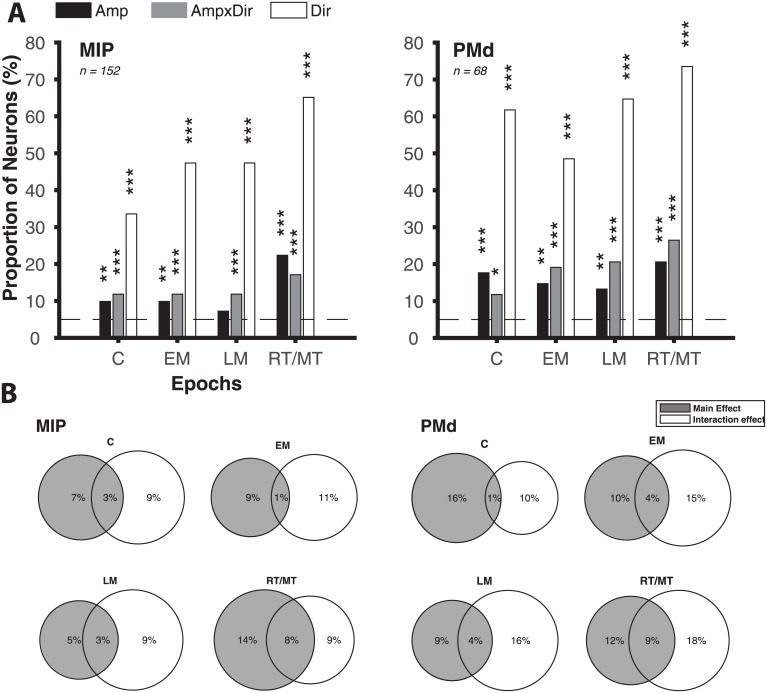
(A) Population analysis of modulation by reach direction and amplitude for both tasks. The proportions of neurons that varied their activity significantly due to the instructed reach direction (black bars), instructed reach amplitude (gray bars), and an interaction of direction and amplitude (white bars) are shown for each of four trial epochs. The two panels correspond to task-related neurons recorded from MIP and PMd respectively, pooling across both target configurations. The proportion expected by chance (“null”, obtained by randomly shuffling the data) is shown with the black horizontal line. Asterisks indicate significance of proportions relative to chance (*: p < 0.05, **: p < 0.01, ***: p < 0.001). (B) Main and interaction effects of reach amplitude. For each cortical area and trial epoch, a Venn diagram shows the proportion of task-related neurons with a significant main effect (gray discs) and interaction effect (white discs) of reach amplitude. The overlap in the two discs (light gray) indicate the proportion of neurons exhibiting both significant main and significant interaction effects due to reach amplitude.